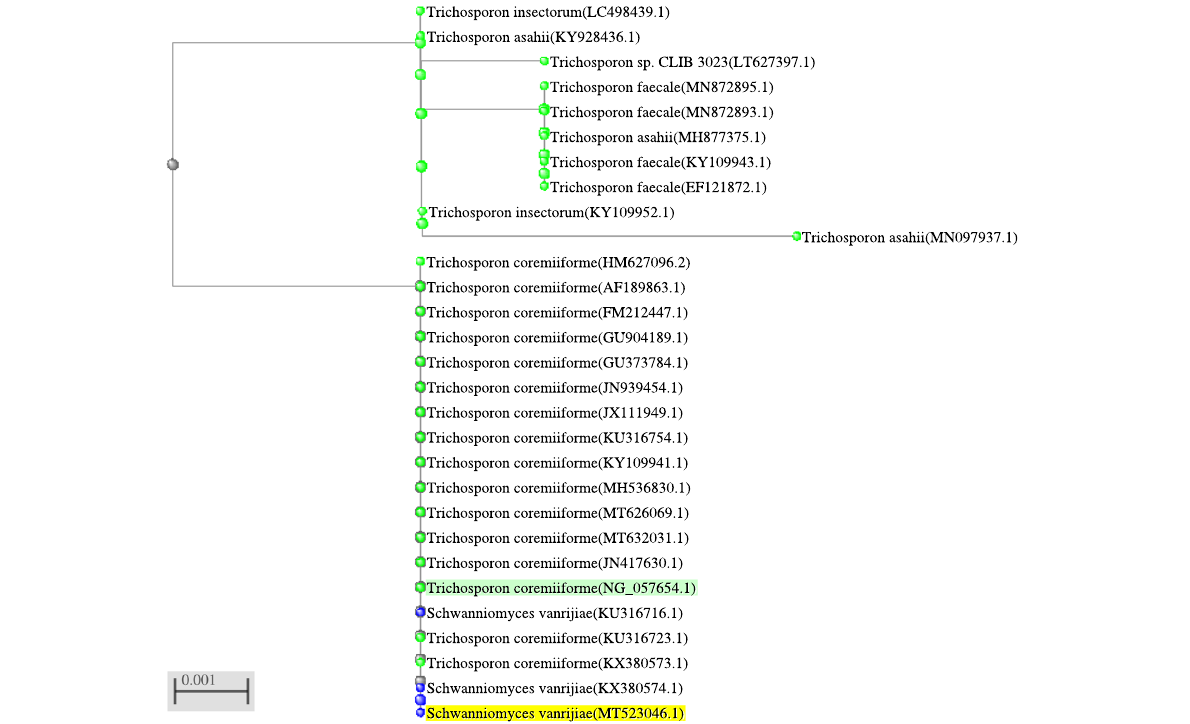
Fig. 1 Phylogenetic analysis of yeast isolate on ITS gene. This analysis was performed using the neighbor-joining method in BLAST pairwise alignments